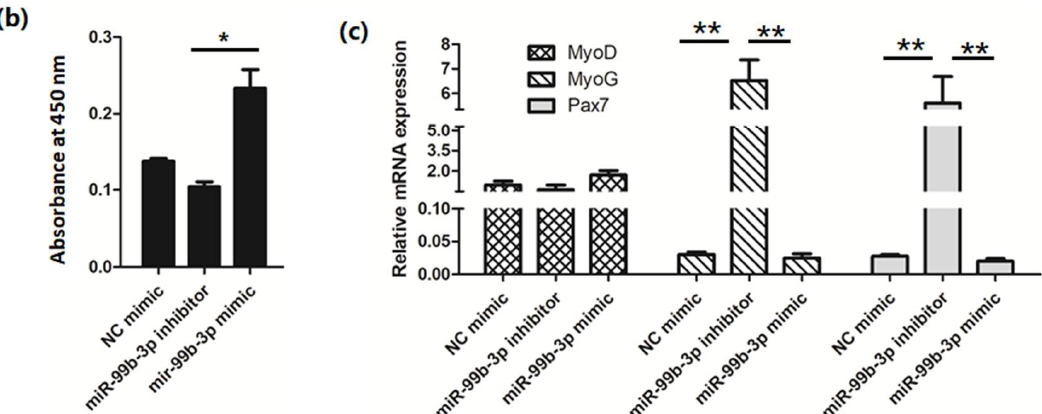
Figure 3. chi-miR-99b-3p regulates cell proliferation and differentiation via the intrinsic apoptotic pathway. ( a ) mRNA and protein levels of apoptosis-related genes after transfection with chi-miR-99b-3p mimic or inhibitor. ( b ) Cell counts detected by CCK-8 analysis. ( c ) mRNA levels of differentiation-related genes after transfection with chi-miR-99b-3p mimic or inhibitor. * p < 0.05; ** p < 0.01. Original Figure 3a in Figure S2.